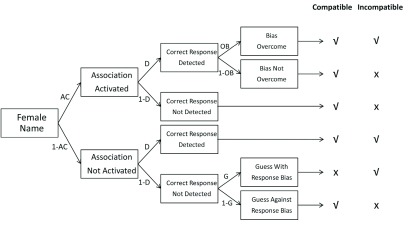
The Quadruple process model (Quad model). Each path represents a likelihood. Parameters with lines leading to them are conditional upon all preceding parameters. The table on the right side of the figure depicts correct (√) and incorrect (X) responses as a function of process pattern and trial type (for ‘‘female’’ targets). The guessing bias in this figure refers to guessing with the positive (pleasant) key (Adapted from Gonsalkorale et al., 2014).